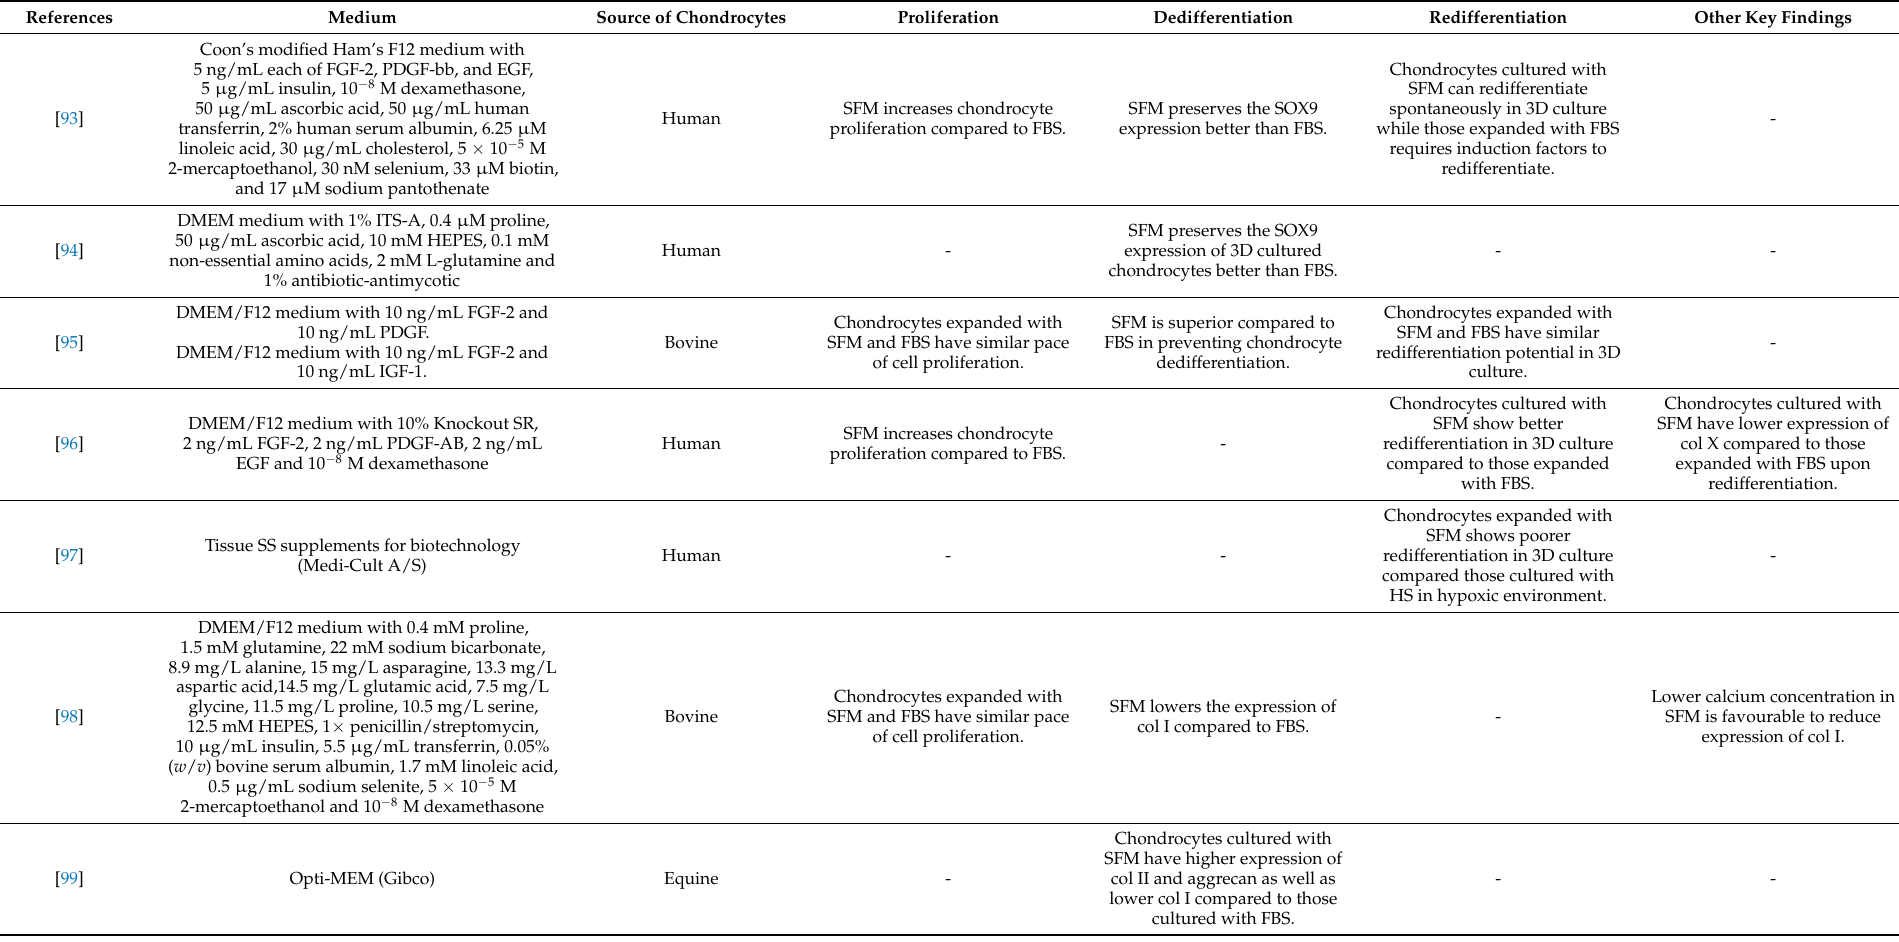
Table 6. Key findings in the studies reported chondrocyte expansion with serum-free